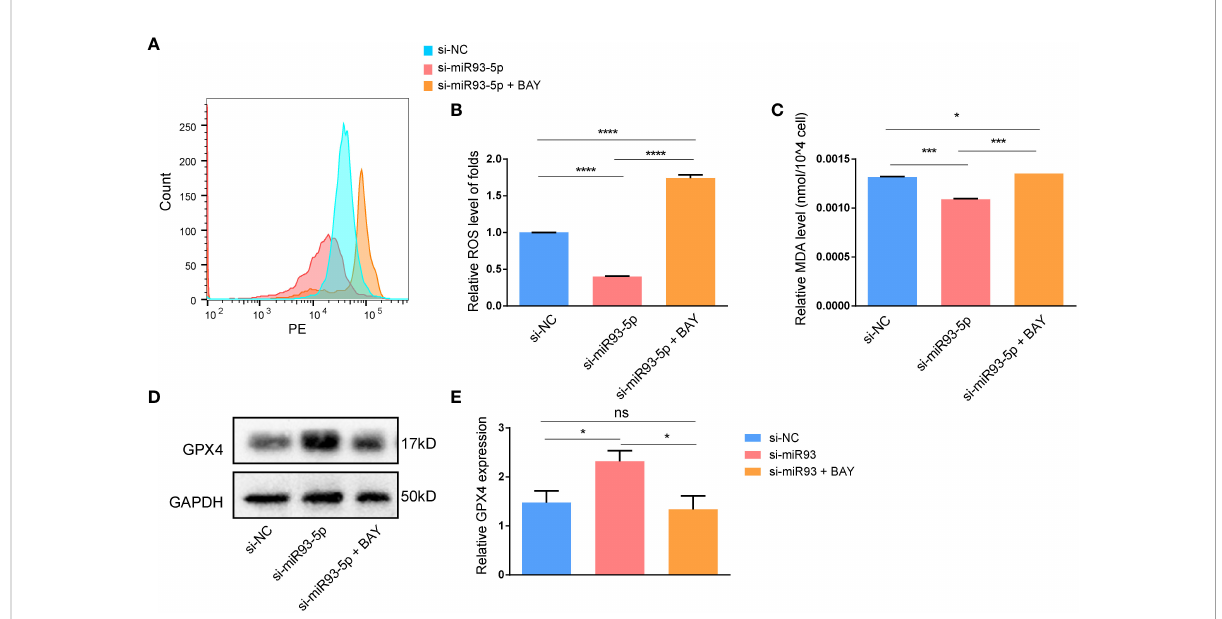
FIGURE 9 The effect of the NF- k B signaling pathway on the ferroptosis in GCs. (A, B) The ROS level was signi fi cantly increased in the si-miR93-5p + BAY group. The relative expression of (C) MDA and (D, E) GPX4 among three groups. p < 0.05 ( “ * ” ), p < 0.001 ( “ *** ” ), p < 0.0001 ( “ **** ” ). ns means no statistical difference.